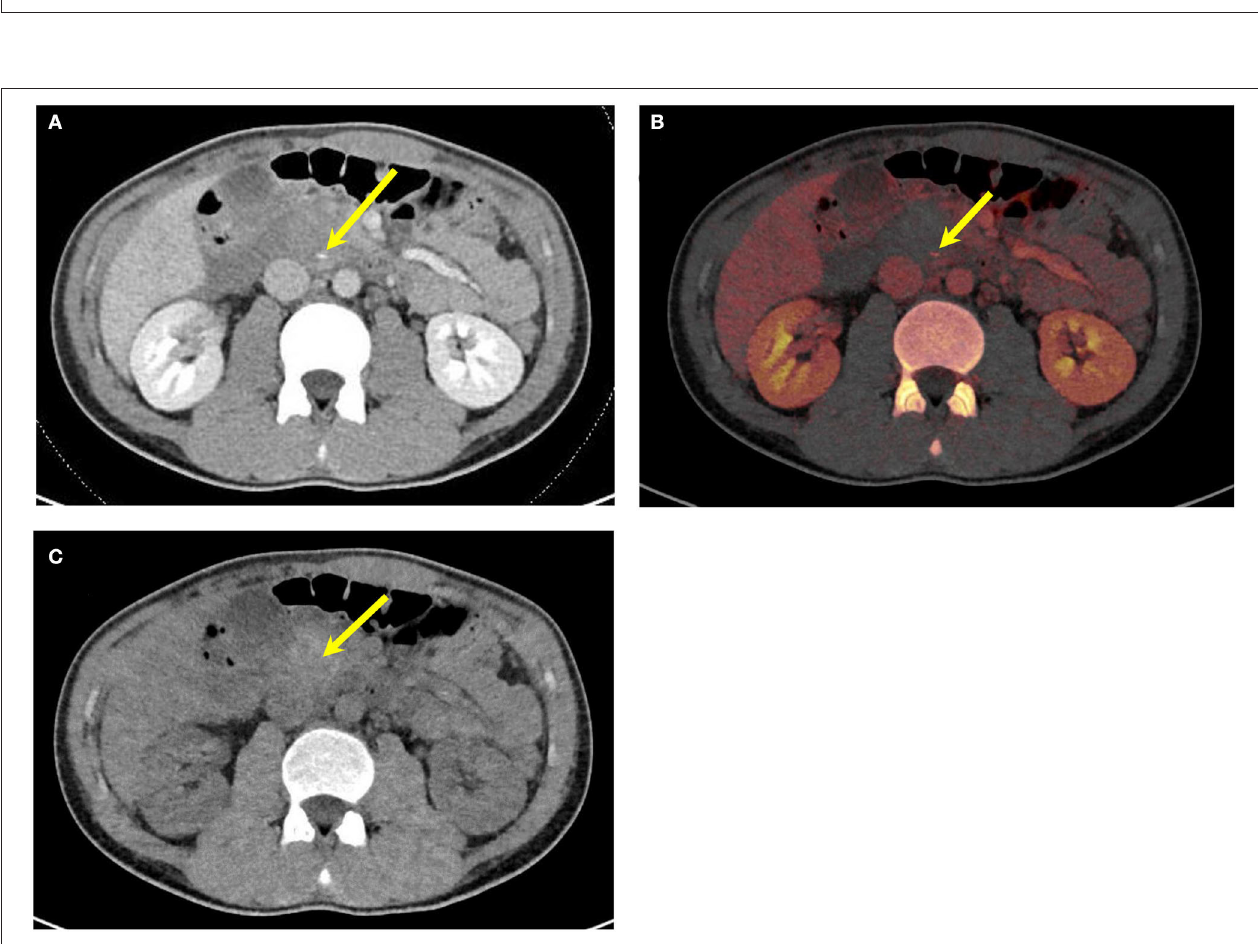
FIGURE 7 | An 18-year-old male patient—hockey stick injury. (A) Conventional mixed DECT image demonstrates intraluminal active contrast extravasation (yellow arrow). (B) Iodine overlay images increase the conspicuity of the intraluminal contrast extravasation (yellow arrow). (C) DECT VNC—focus of contrast is not seen on DECT VNC, confirming the hyperdensity is contrast and not pre-existing on nonenhanced CT (yellow arrow). DECT, dual-energy CT; VNC, virtual non-contrast.